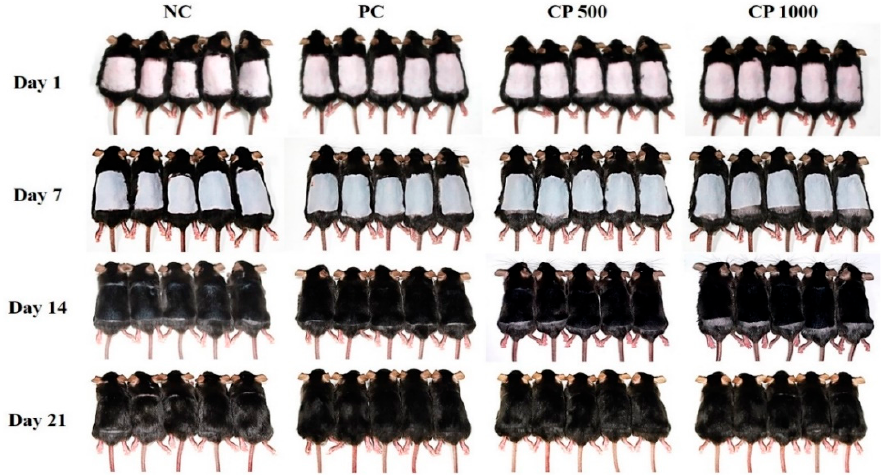
Figure 2. Effect of CP on anagen phase induction in C57BL/6 mice after depilation. Before and after depilation, distilled water (vehicle), finasteride (1 mg/kg in distilled water), and CP (500 and 1000 mg/kg in distilled water) were orally administrated to each group for 6 weeks. Dorsal skins were photographed on days 1, 7, 14, and 21 after depilation. NC: negative control (distilled water); PC: positive control (finasteride); CP500: collagen peptide, 500 mg/kg; CP1000: collagen peptide, 1000 mg/kg.